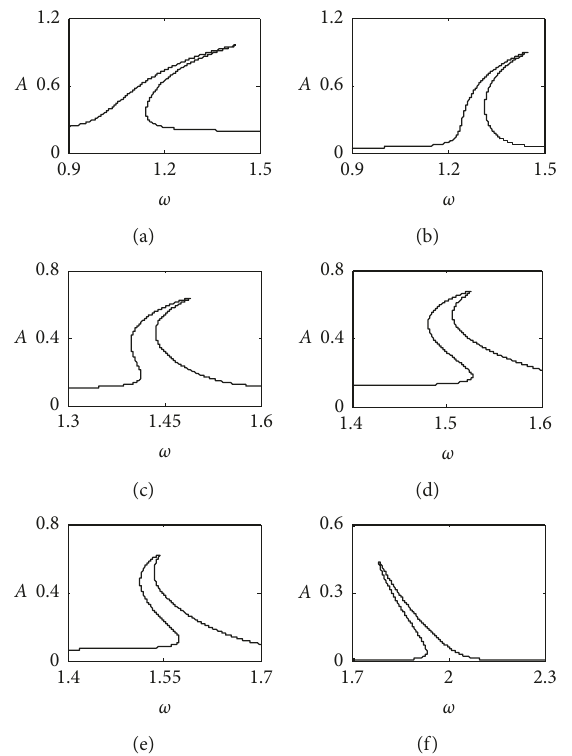
Figure 9: Amplitude-frequency curve. (a) F � 0.9, (d) F (c) F I